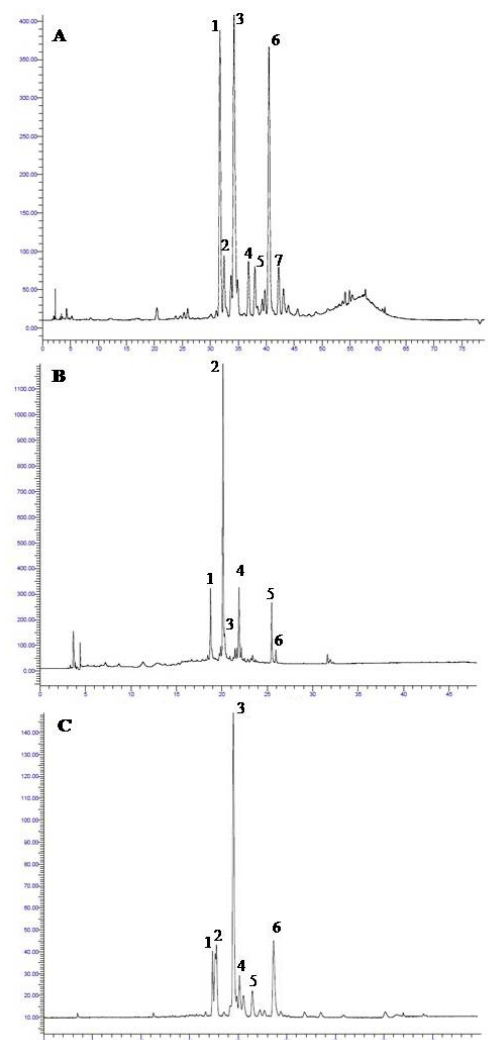
Figure 1. Chromatograms (350 nm) of leaf ethanolic extracts of Phillyrea latifolia ( A ), Cistus incanus ( B ) and Pistacia lentiscus ( C ). In P. latifolia ( A ), rutin (1), luteolin-7-O-rutinoside (2), luteolin-7-O-glucoside (3),kaempferol derivative (4), caffeic acid derivative (5), luteolin-4’-O-glucoside (6) and luteolin-7-O-derivative (7) were the major compounds. In C. incanus ( B ) myricetin-3-O-glucoside (1), myricitrin (2), quercetin-3-O-glucoside (3), rutin (4), quercetin-3-O-pentoside (5), and quercitrin (6) were the most abundant flavonoids. In P. lentiscus ( C ), myricetin-3-O-galactoside (1), myricetin-3-O-rutinoside (2), myricitrin (3), myricetin derivative (4), quercetin-3-O-arabinoside (5), and quercitrin (6) were detected.